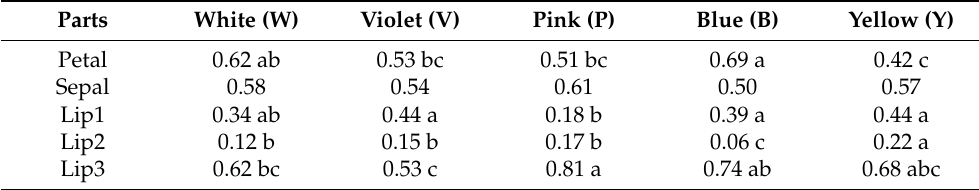
Table 2. Comparison of cell shape measurements and morphologies among different parts of Bletilla flowers, with White (W), Violet (V), Pink (P), Blue (B), and Yellow (Y) color variations. Parts